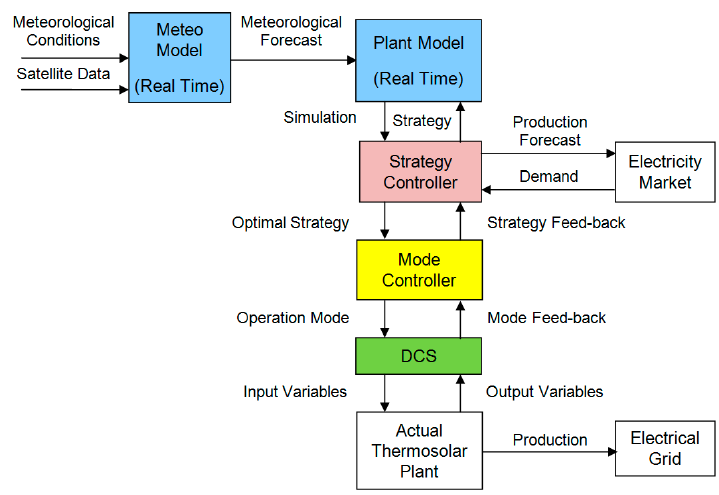
Figure 1. Ideal future block diagram for the control of a solar thermal power plant.